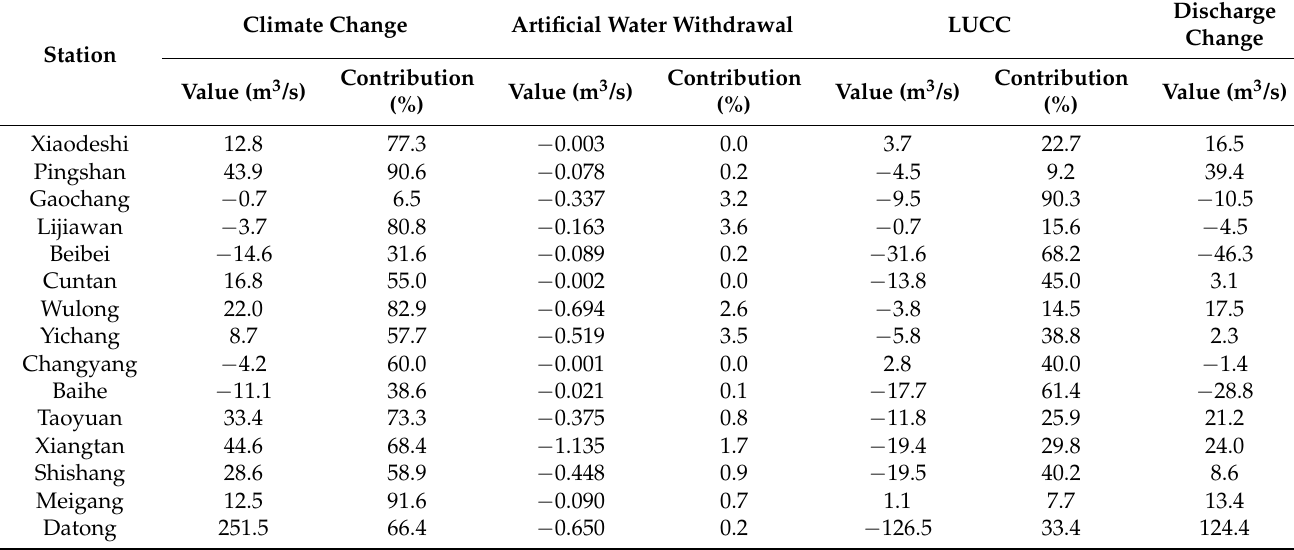
Table 5. The contribution rate of various factors to the variation in the discharge of 15 hydrological stations in the Yangtze River